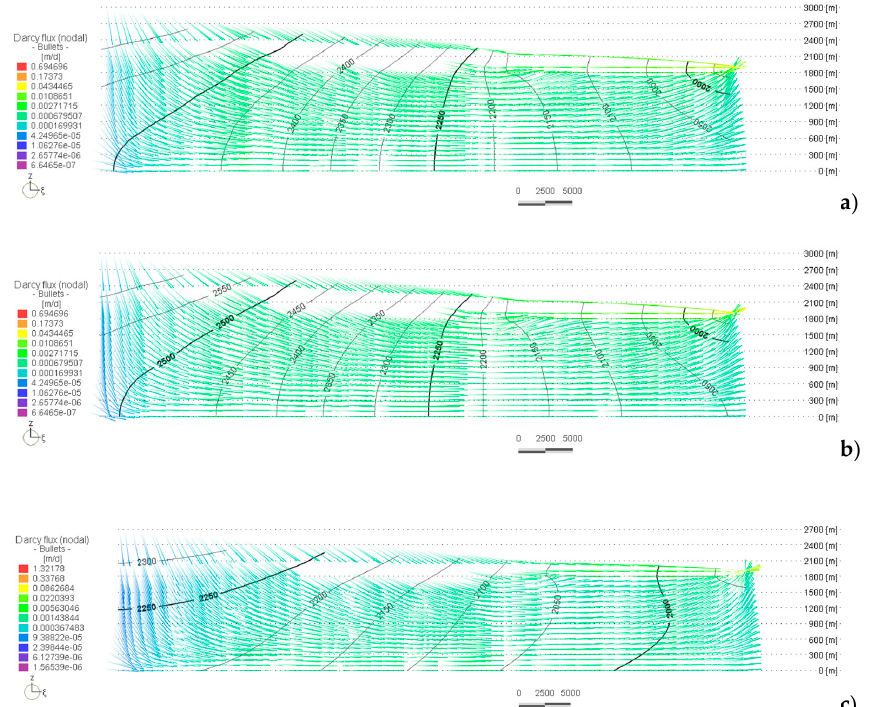
Figure 7. Cross-sections of W-Laja. Distribution of Darcy flow equipotential lines for: ( a ) isothermal, scenario I; ( b ) convective 1, scenario II; and ( c ) convective 2, scenario III, see Table 1. Vertical exaggeration of the scale is 5:1 and 8:1 for the bullets in Darcy flux.